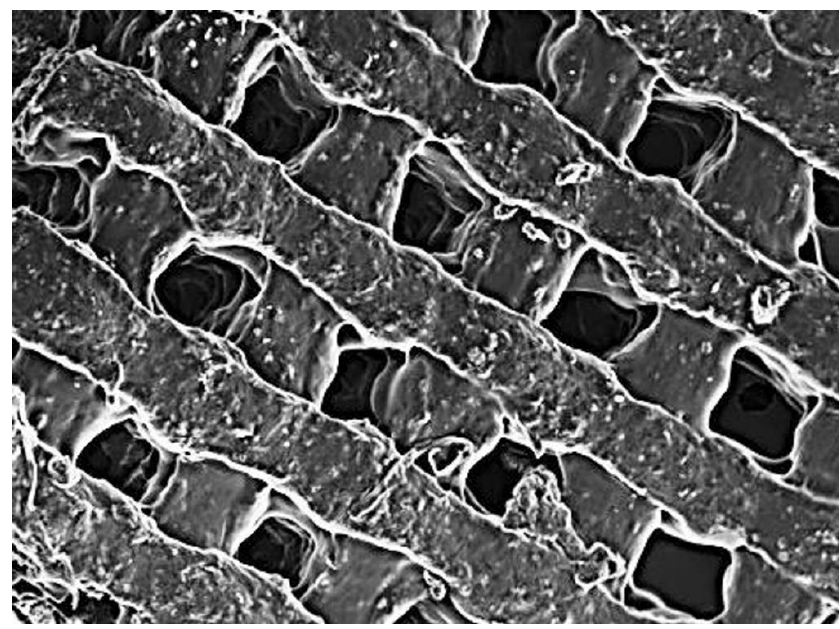
Figure 8. The examples of the physical photo of the 3D-printed biomaterial scaffold. Table 2. Modified parameters were used for the 3D printing of the biomaterial scaffolds.